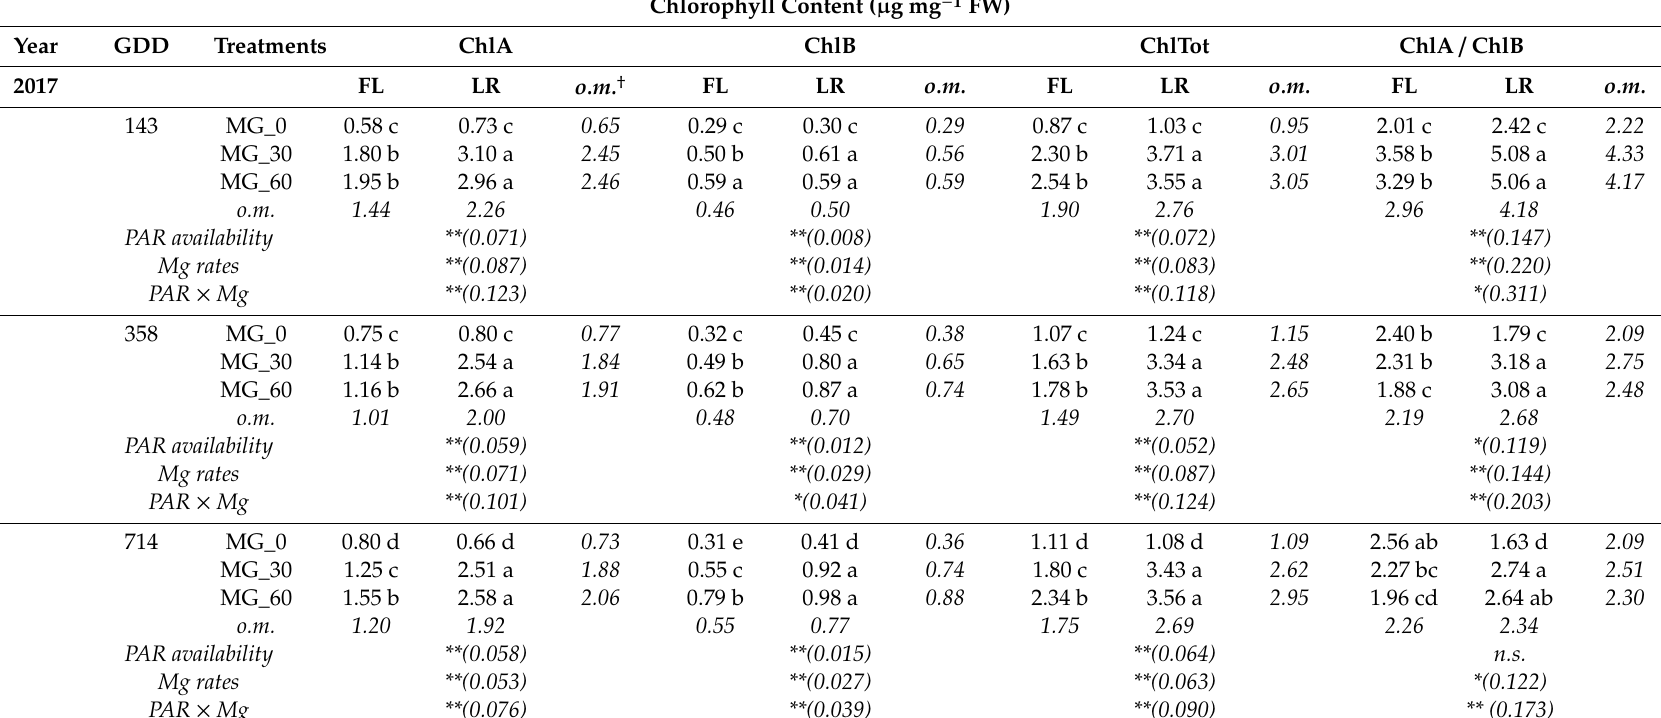
Table 3. Chlorophyll content ( µ g mg − 1 FW) in leaves of red beet plants subjected to two levels of photosynthetically active radiation (PAR) availability (100% PAR availability: Full Light, FL; 50% PAR availability: Light Reduction, LR) and three magnesium (Mg) application rates (0 kg ha − 1 of Mg: MG_0; 30 kg ha − 1 of Mg: MG_30; 60 kg ha − 1 of Mg: MG_60) at 143, 358 and 714 Growing Degree Days (GDD, ◦ C) after transplanting in 2017 and at 158, 376 and 724 GDD after transplanting in 2018. Measurements are average values of three replications. Means followed by di ff erent letters (upper case letters: main e ff ects; lower case letters: e ff ects of interaction) significantly di ff er (Fisher’s LSD, p ≤